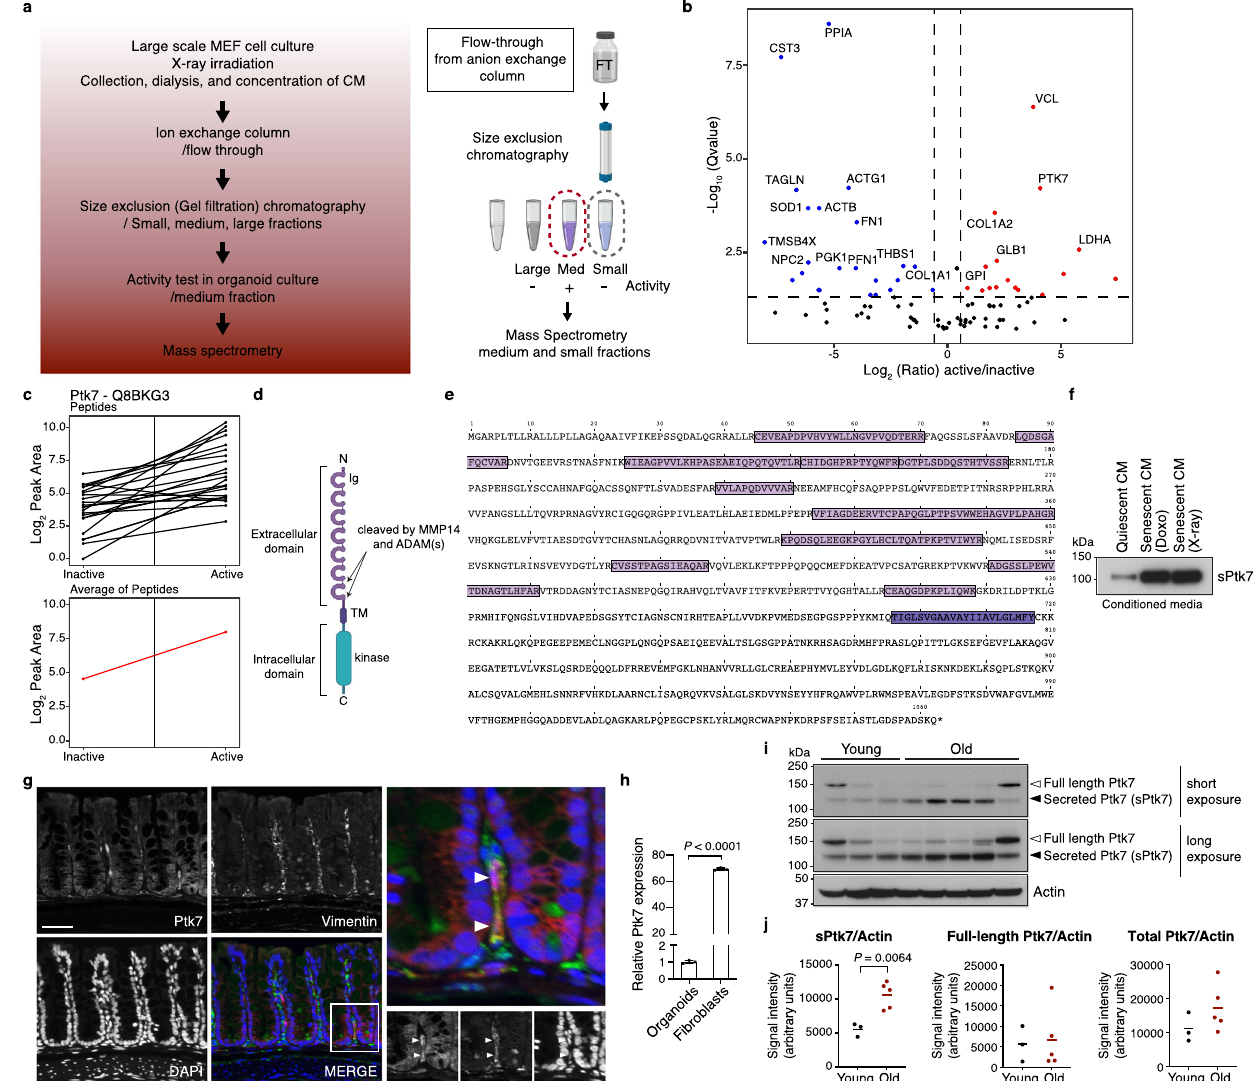
Fig.2|Identi fi cationofPtk7asafactorthatcausescysticorganoidphenotype. a Schematic showing conditioned media preparation, columnpuri fi cation, activity test, and mass spectrometry (MS). The fi gure was created with BioRender.com. b Volcano plot representing the statistical signi fi cance and protein abundance ratiosbetweenmedium(active)andsmall(inactive)fractions.Dashedlinesdepicta q =0.05 cutoff (horizontal) and 1.5-fold difference cutoffs (vertical). Proteins that arepresenthighlyinmedium(active)andsmall(inactive)fractionsarerepresented in red and blue, respectively. Proteins with q <0.01 and more than 1.5-fold differ- ence are labeled. c Graphs showing peptide peak area pro fi les for Ptk7. Each Ptk7 peptide detected is shown as a black line, indicating the peak area measurements fortheinactiveandactivefractions.TheaverageofallPtk7peptidesispresentedas a red line. d Schematic representation of the Ptk7 protein domain structure. Ig: Immunoglobulin-like loops (lilac), TM: a transmembrane region (purple), and an inactive tyrosine kinase domain (blue). e A graphic representation of the list of peptides detected by MS. Ptk7 peptide sequences detected by MS in lilac and the